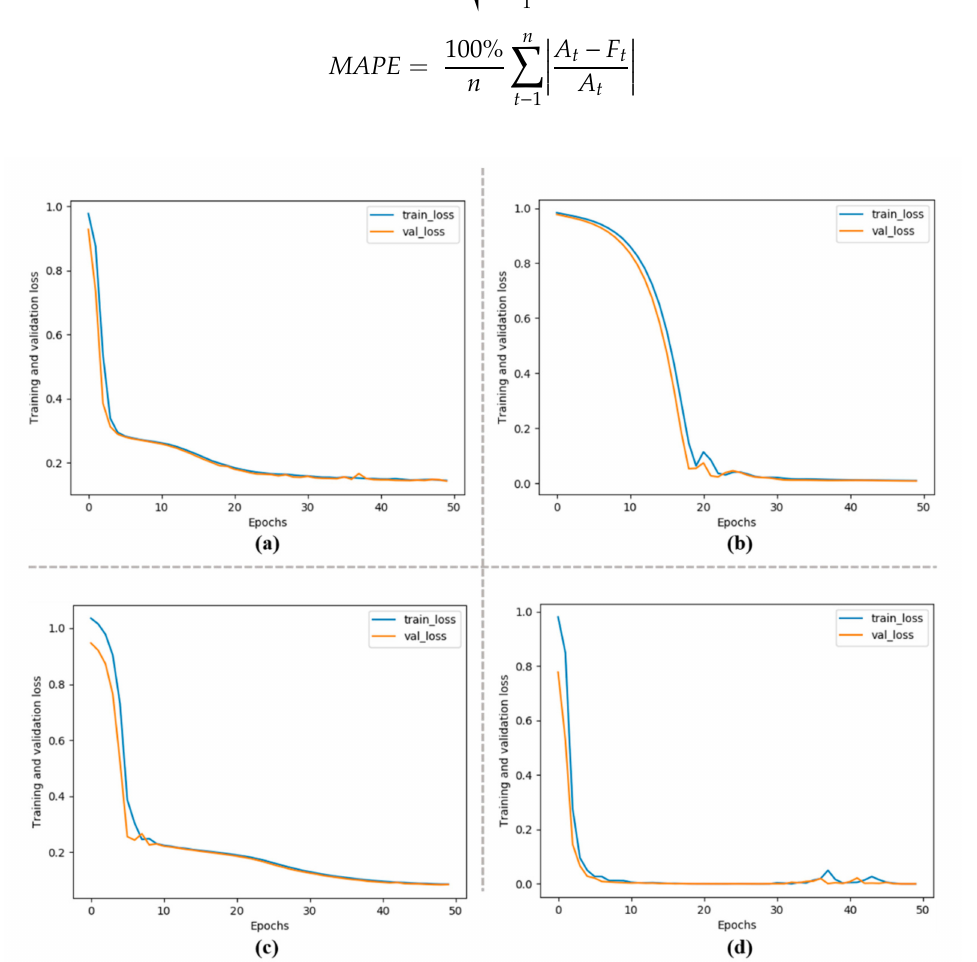
Figure 7. Training and validation loss during